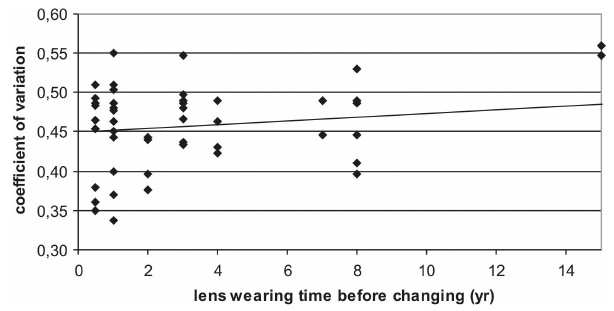
Fig. 4. The °uctuation of cell size in Group 2. Cell size changes are not synchronized with cell density changes because they are reversely interdependent.